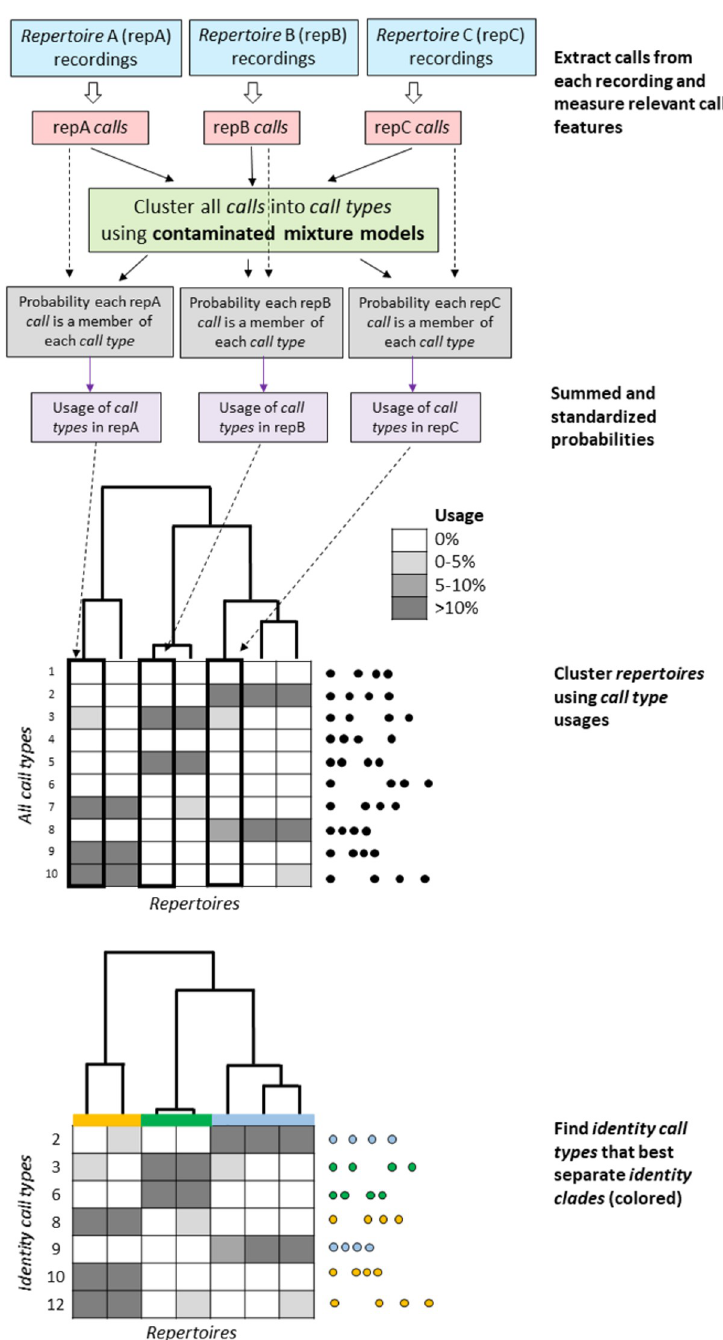
Fig 1. The major elements of IDcall framework. The recordings of sounds are delineated into identity clades based on the identity calls that characterize